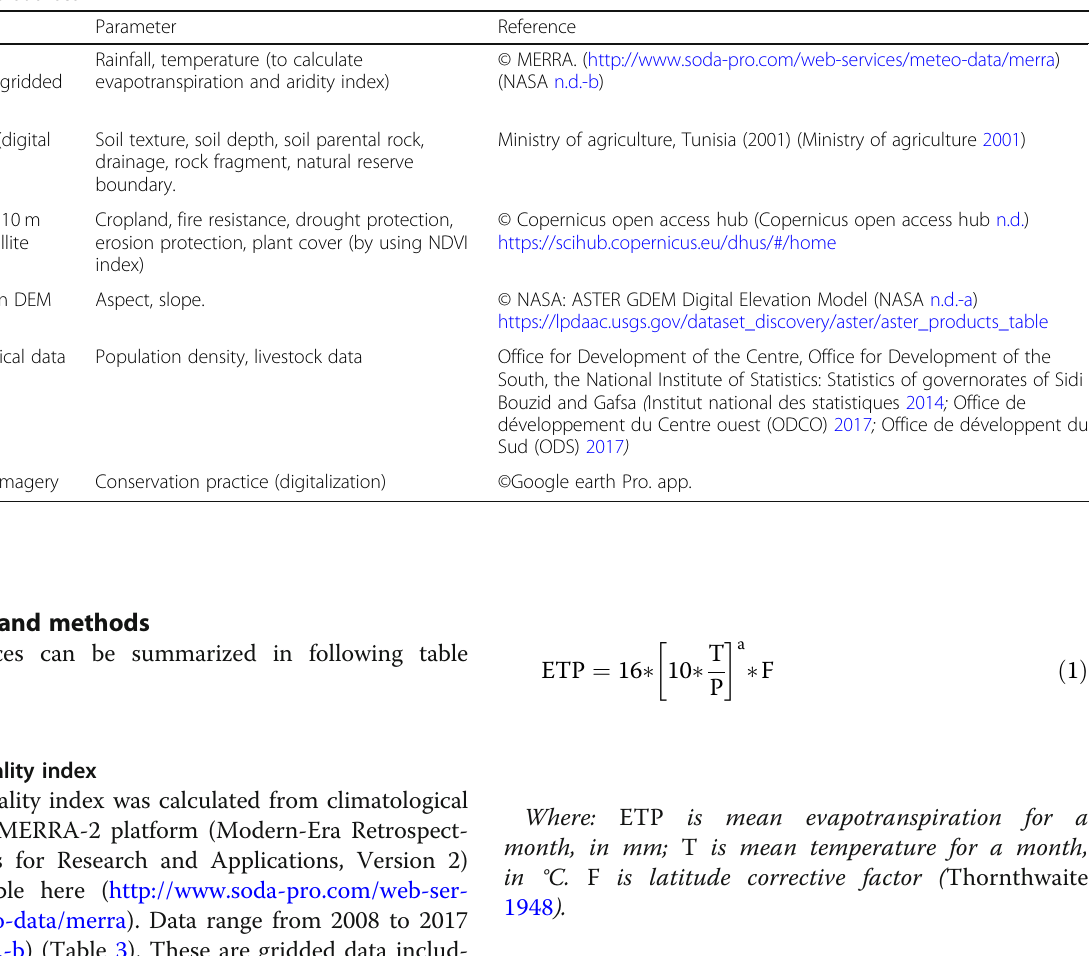
Climate quality index